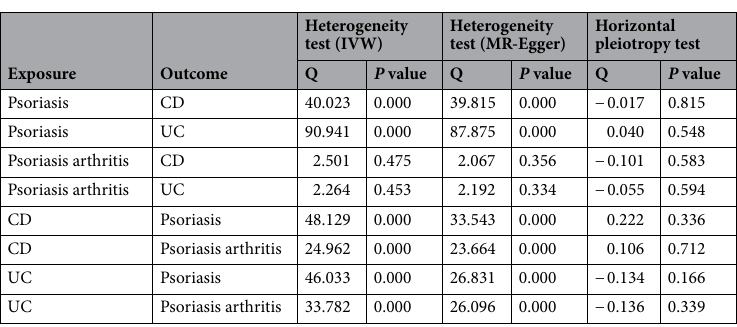
Table 1. Heterogeneity test and horizontal pleiotropy test. IVW inverse variance weighting, MR Mendelian randomization, CD Crohn’s disease, UC ulcerative